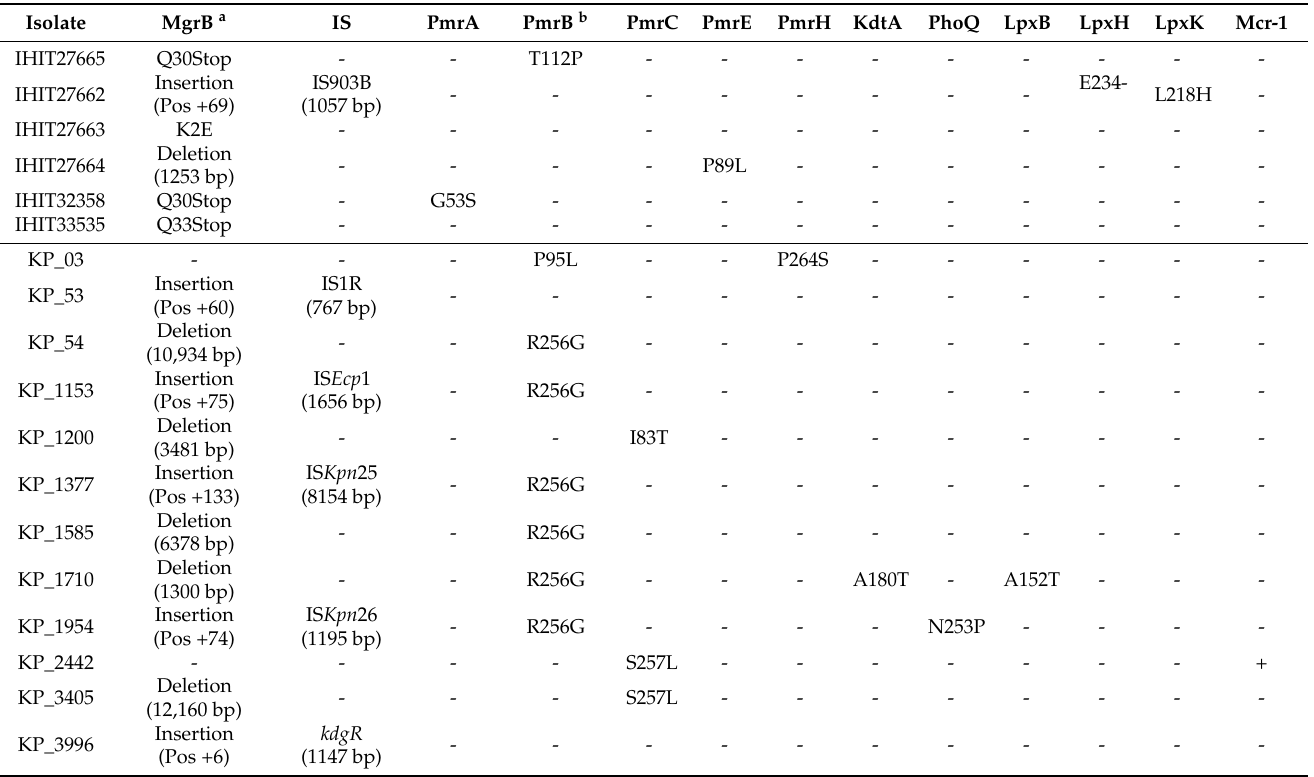
Table 3. Mutations in putative COL resistance genes in veterinary and human K. pneumoniae